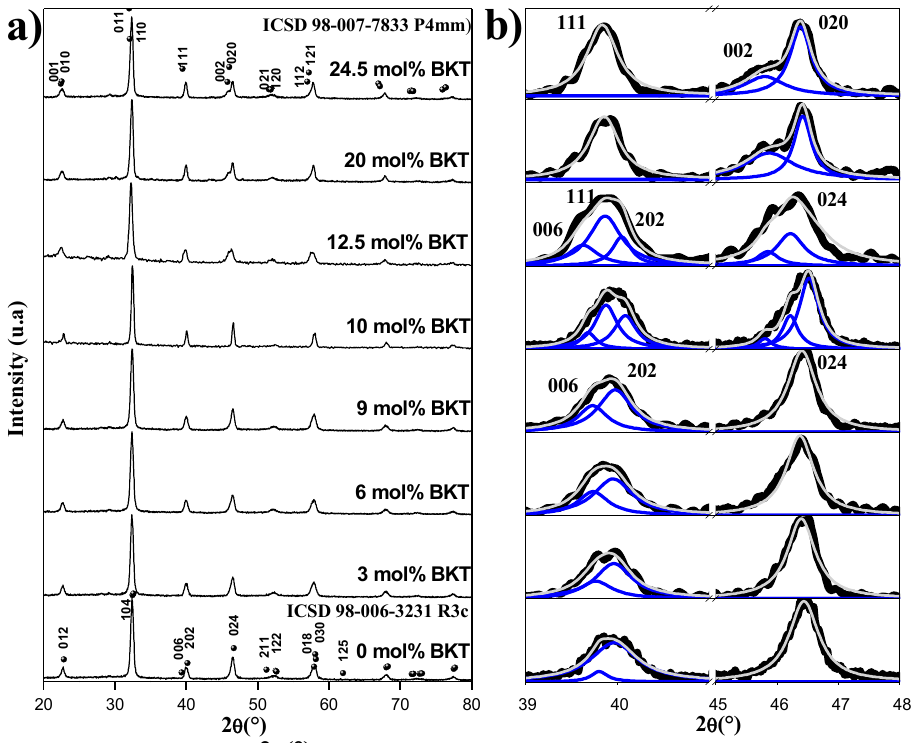
Figure 1. XRD patterns of sintered ceramics in compositions (97.5 − x )BNT + x BKT + 2.5BT with x = 0, 3, 6, 9, 10, 12.5, 20, and 24.5 mol % BKT ( a ) from 20–80 in 2 θ (°) and ( b ) deconvoluted peaks between 39–48 in 2 θ (°).